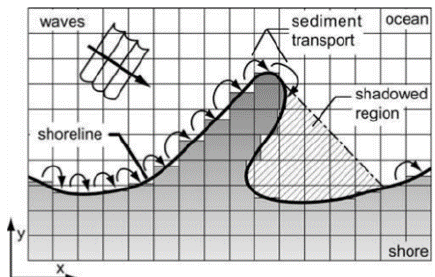
Figure 3. Plan-view schematic of CEM showing the shadow zone that is formed when protruding sections of coastline prevent waves from approaching the shoreline (Ashton and Murray,